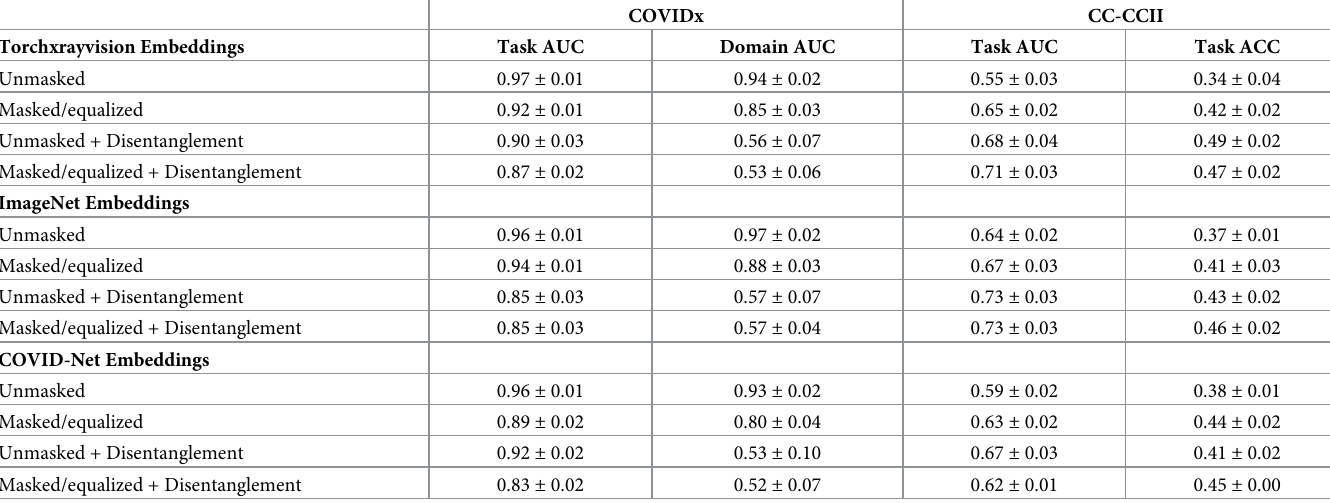
Table 3. Results showing within-dataset class performance, within-dataset domain performance, and out-of-sample class performance from training models with the COVIDx dataset. The task performance (task AUC and task accuracy) shows how well classifiers are able to distinguish between “Normal”, “Pneumonia”, and “COVID-19+” disease labels, while the domain performance (domain AUC) shows how well classifiers are able to distinguish which sub-dataset an image belongs to. We report AUC values as averages of the one-vs-all binary AUCs between all classes, and accuracy (ACC) as the average accuracy over all classes. In all cases class performance (both within-dataset and out-of-sample) is reported from the classifier trained on samples within-dataset, while domain performance is reported from an additional classi- fier trained to predict domain labels on top of the learned representations, z 0 , as a measure of how much domain information the representation contains. We observe that using feature disentanglement decreases within-dataset domain performance as expected, and increases out-of-sample class performance—i.e. improves generalization